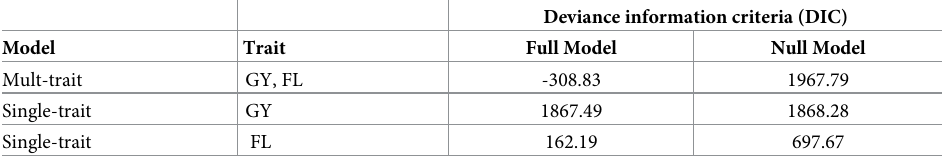
Table 1. Deviation information criteria for the full (considering the G x E interaction) and null (not considering the interaction)